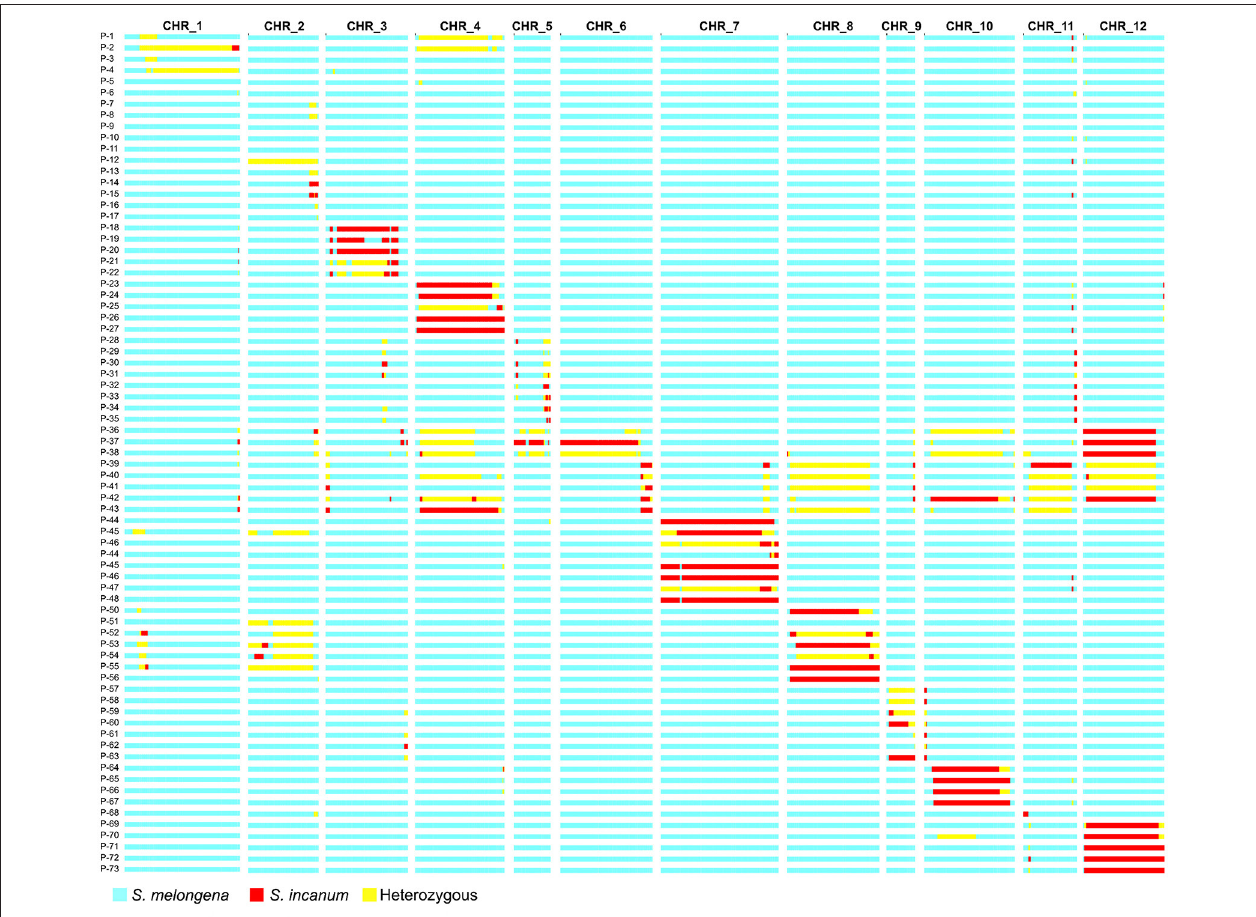
FIGURE 3 | Graphical genotypes of the selected plants genotyped by genotyping-by-sequencing (GBS) after four to five (two for P-36 to P-43) rounds of backcross (typically five, but two or four for some genotypes) and one round of selfing, using Solanum incanum MM577 as the donor parent in the genetic background of S. melongena AN-S-26. The first row indicates chromosome number and the first column the plant code. Homozygous introgressions of the donor parent are depicted in red, while the genetic background of the recipient parent is depicted in blue and the heterozygous regions in